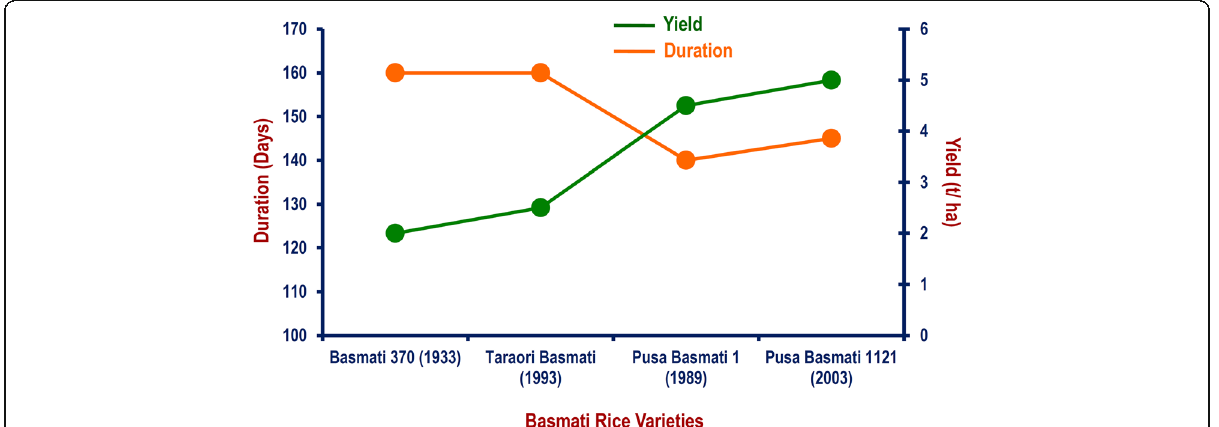
Fig. 4 Duration and grain yield of PB 1121 as compared to Basmati 370, Taraori Basmati and Pusa Basmati 1; Year of release of the variety is indicated in the